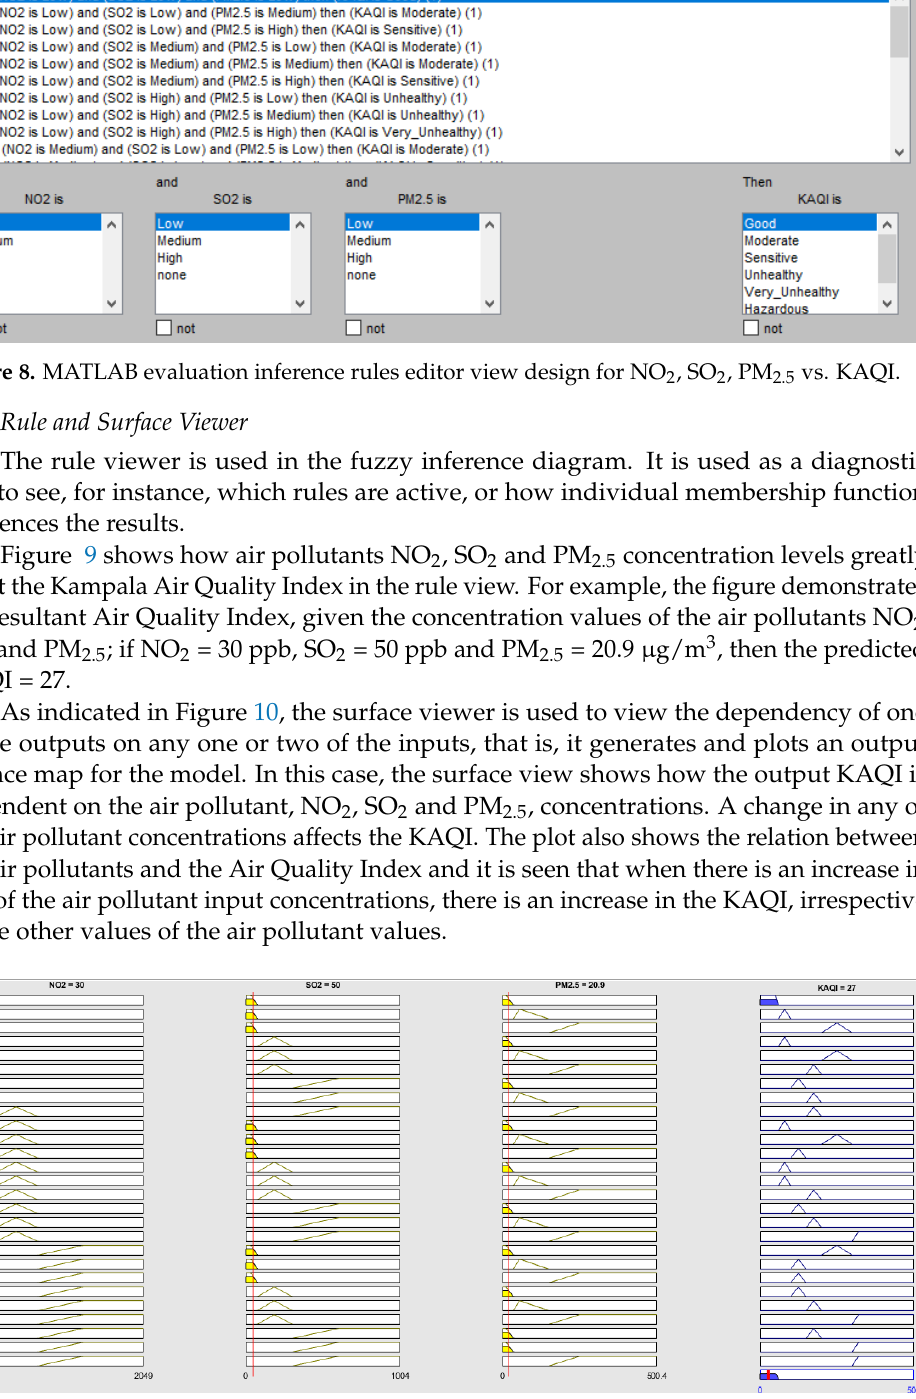
Figure 9. Active rules and Membership functions of input NO 2 , SO 2 , PM 2.5 vs. output of